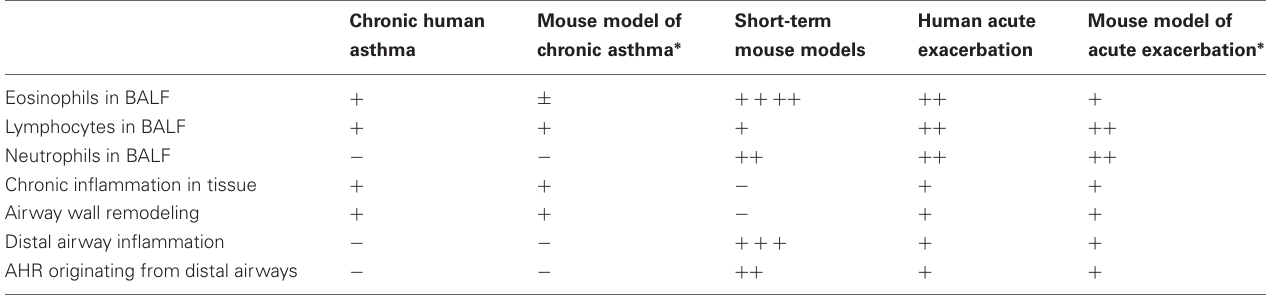
Table 1 | Comparison of human asthma and various mouse